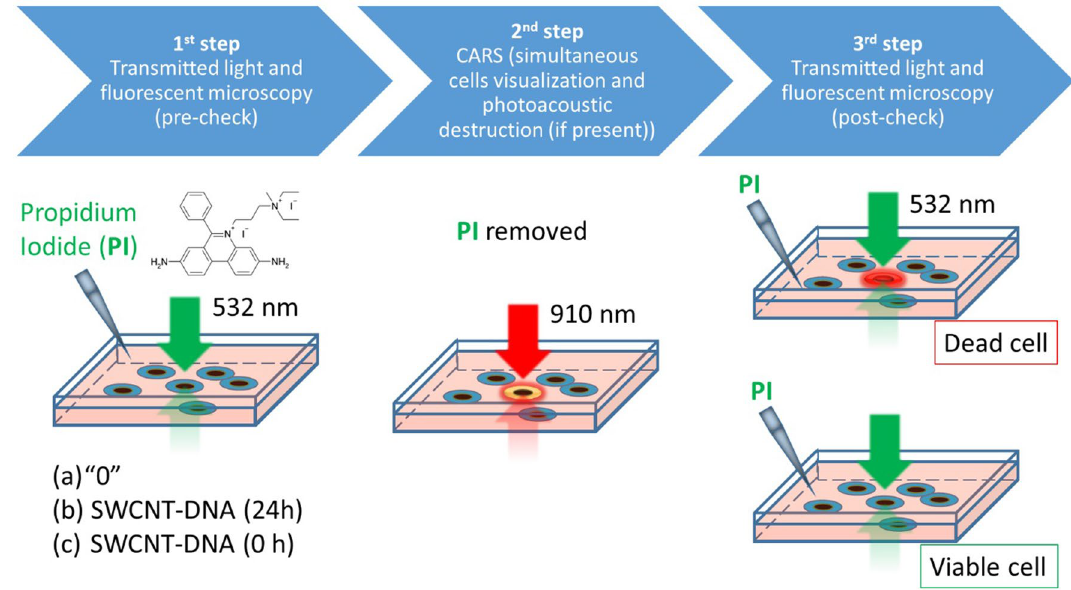
Figure 4. Experimental scheme for determination of glioma cell viability after NIR pulsed irradiation. ( a ) Cells without SWCNTs (control), ( b ) cells accumulated SWCNTs in the cytoplasm as micro-sized agglomerates, ( c ) cells exposed to stable suspension of individual